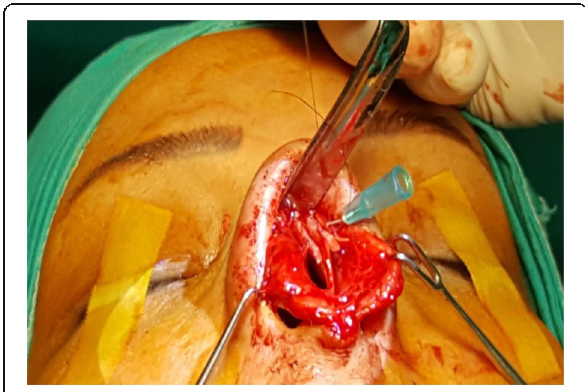
Fig. 2 Fixation of a spreader graft by PDS sutures